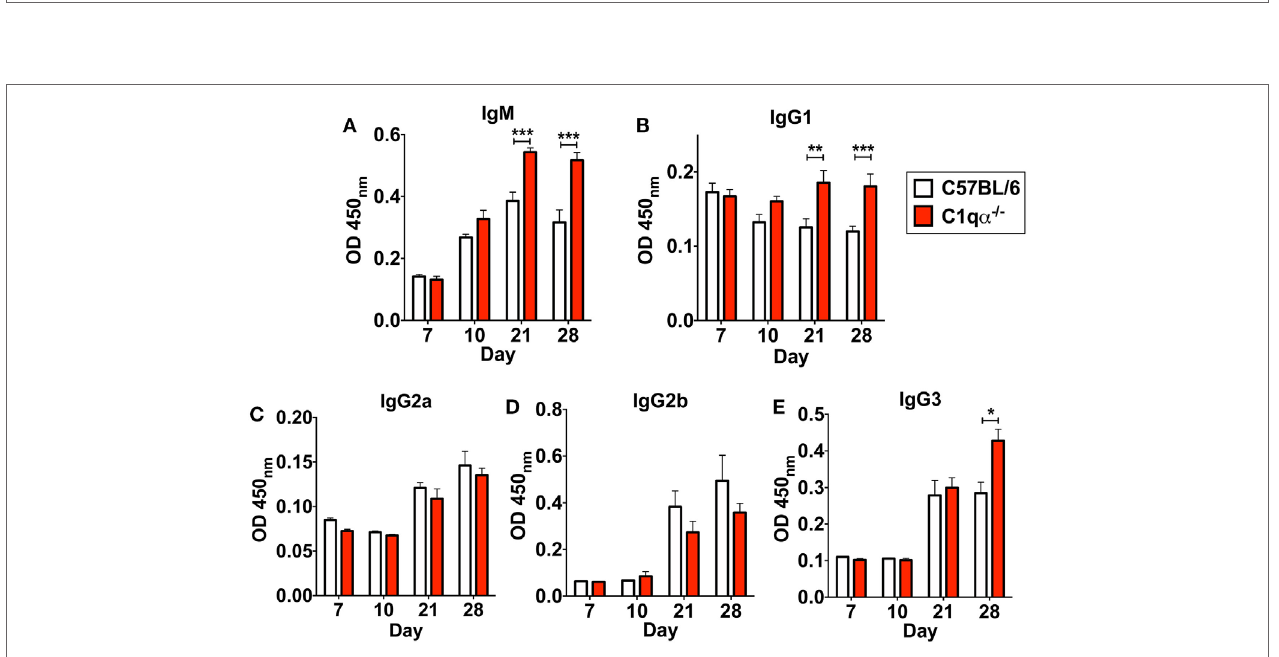
FigUre 6 | Lack of C1q alters the level of Borrelia -specific antibody subtypes IgM (a) , IgG1 (B) , IgG2a (c) , IgG2b (D) , and IgG3 (e) in infected mice. Whole blood was collected from mice infected with 10 4 Borrelia burgdorferi strain MSK5 (24) at 7, 10, 21, and 28 days post-infection. Serum level of Borrelia -specific immunoglobulin subtypes was determined by ELISA using total protein lysate derived from B. burgdorferi strain MSK5. White columns refer to C57BL/6 mice, whereas red columns represent data from C1q α − / − mice ( n = 5; * P < 0.05; ** P < 0.01; and *** P < 0.001).